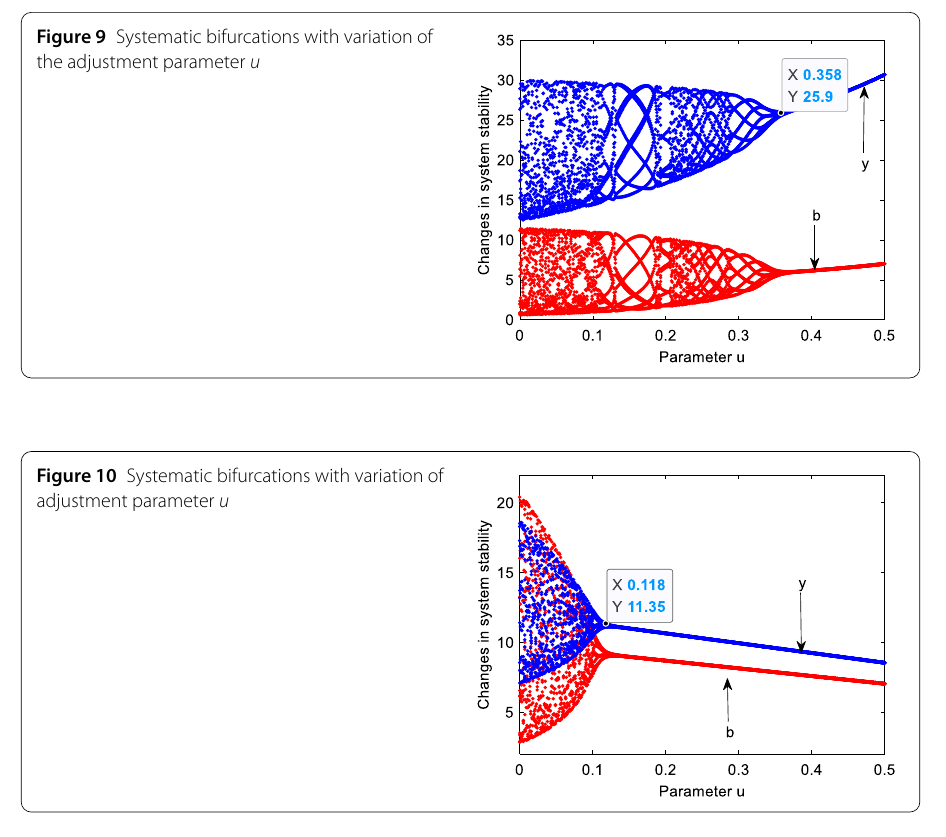
Figure 9 Systematic bifurcations with variation of the adjustment parameter u